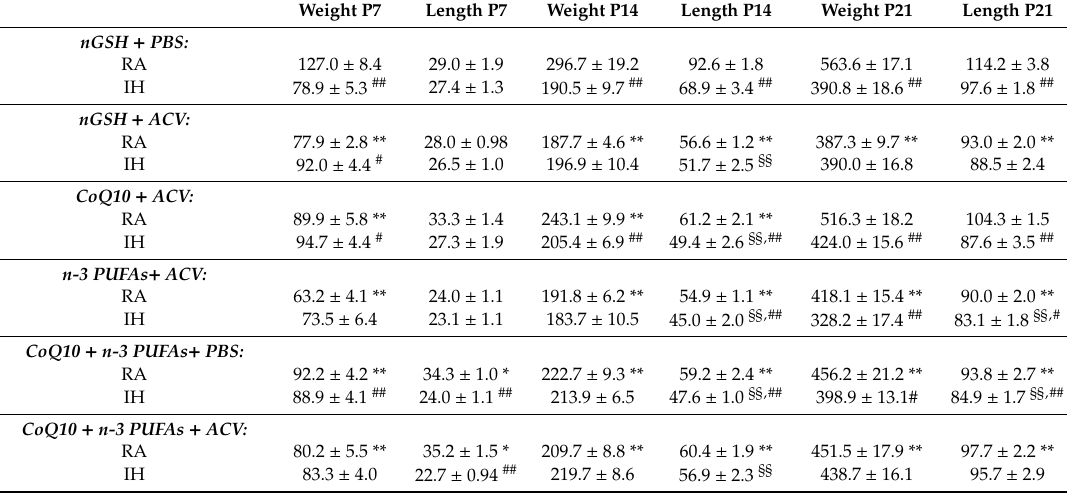
Table 1. % Change in Growth from P0